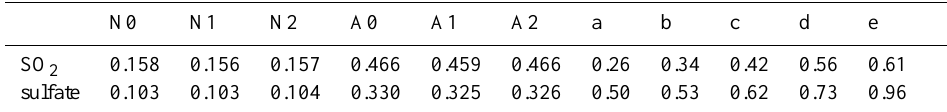
Table 3. Global sulfur burden (in TgS) calculated from different sets of GCCM simulations and comparison with those from a few models that also applied the 1985 GEIA emission inventory.